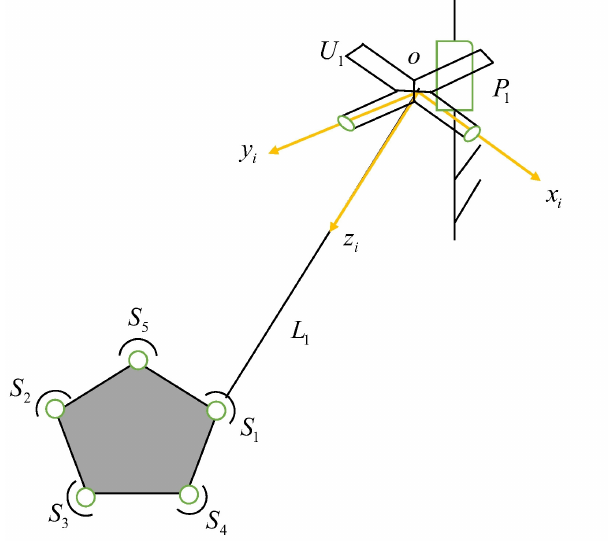
Figure 2. Sketch of limb